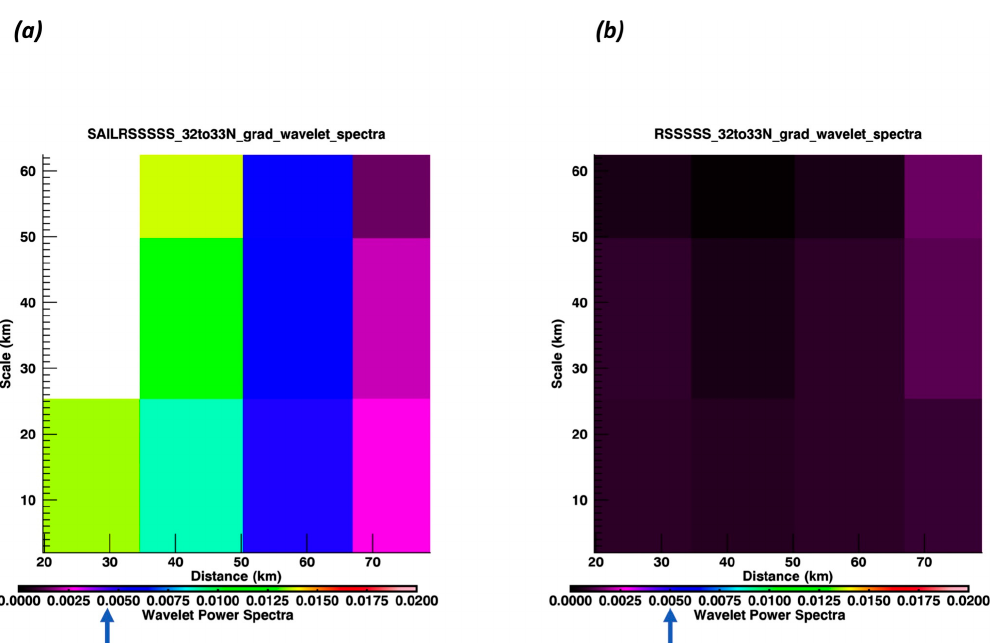
Figure 11. ( a , b ). Wavelet spectra from 32°N to 33°N for ( a ) SAILSSS and ( b ) RSSSSS. Arrows indicate the color associated with the 95% level of confidence.